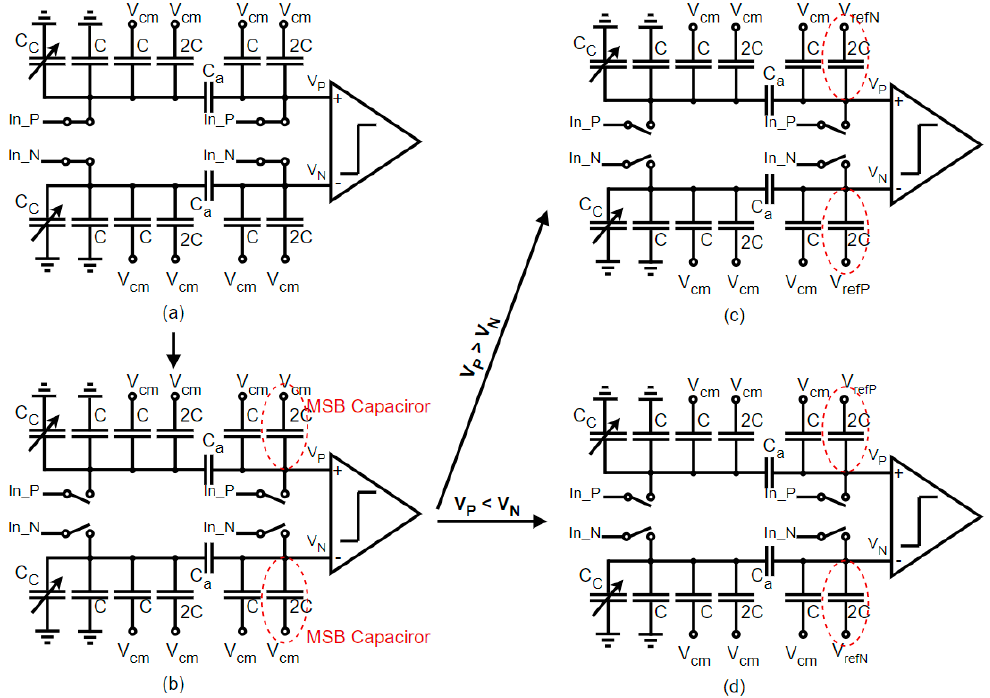
Figure 4. First steps of this SAR switching algorithm in a limited 4-bit example. ( a ) Sampling phase; ( b ) First comparison; ( c ) Second comparison if b 0 = 1; ( d ) Second comparison if b 0 = 0.